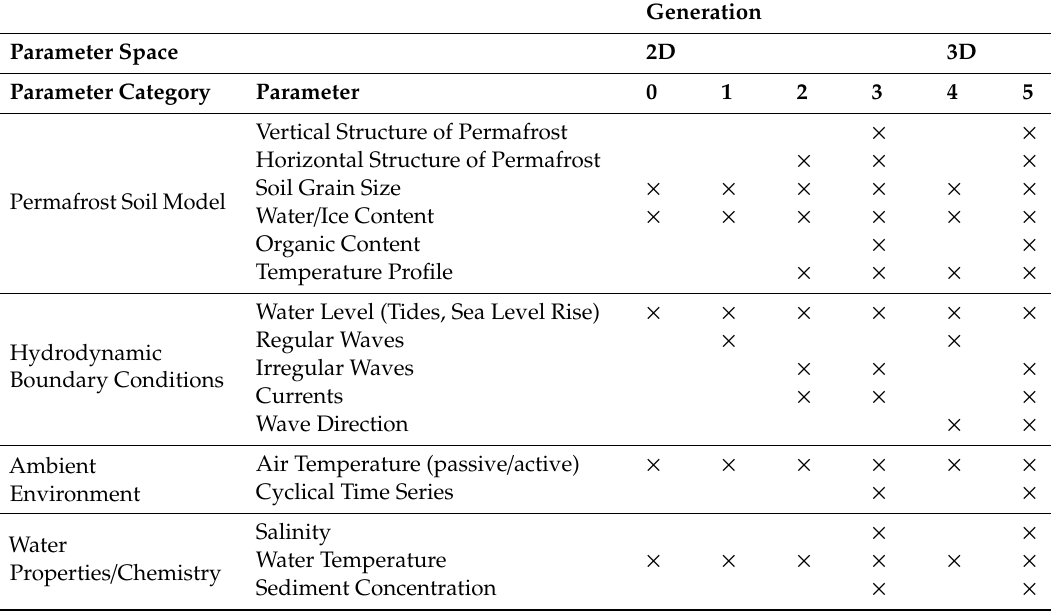
Table 1. Generational model approach (Generation 0–5) addressing the parameters critical to the process of thermomechanical